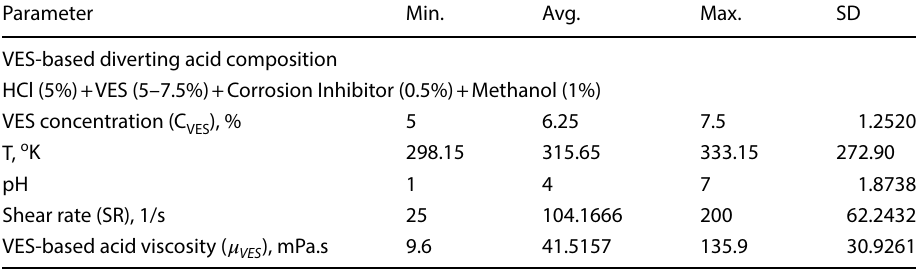
Table 1 Details of the experimental data sets gathered from the literature